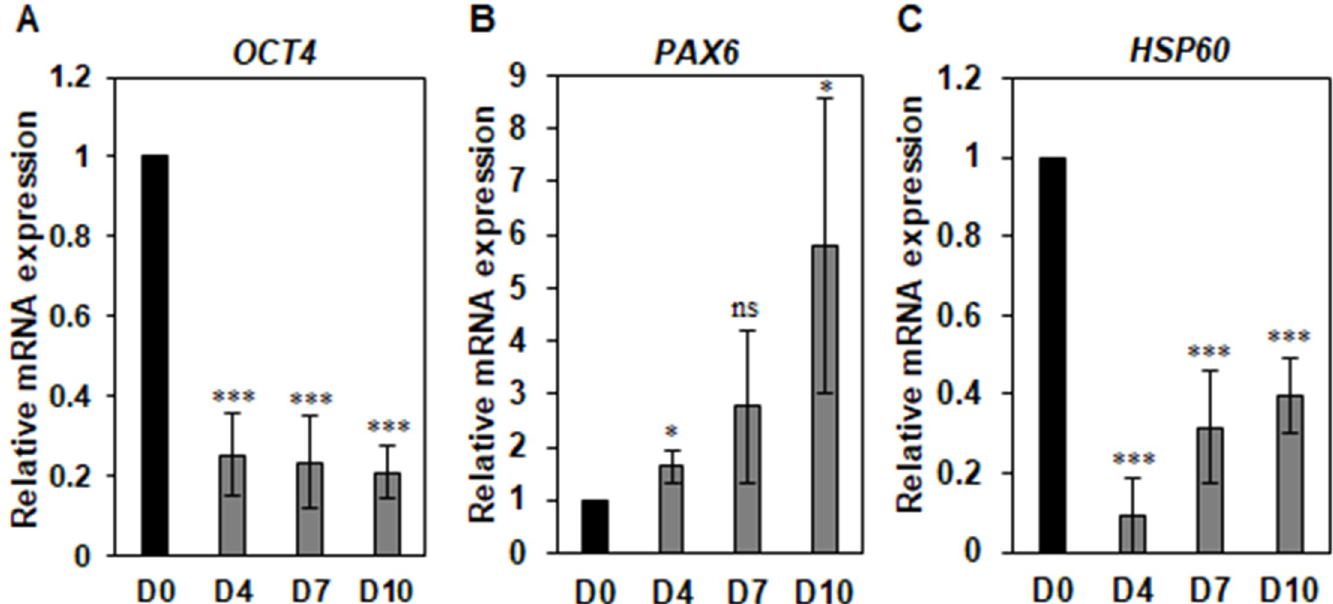
Fig 4. Expression kinetics of HSP60 during EB differentiation of primed hPSCs. Primed H9 hPSCs were differentiated by EB formation for 10 days. The expression of OCT4 , PAX6 , and HSP60 genes was determined by qPCR. qPCR data are presented as relative expression changes considering expression in undifferentiated hPSCs (Day 0) as 1. The graphs represent the mean values of three independent determinations ± SD (ns, not significant; � , p < .05; ��� , p < .005).